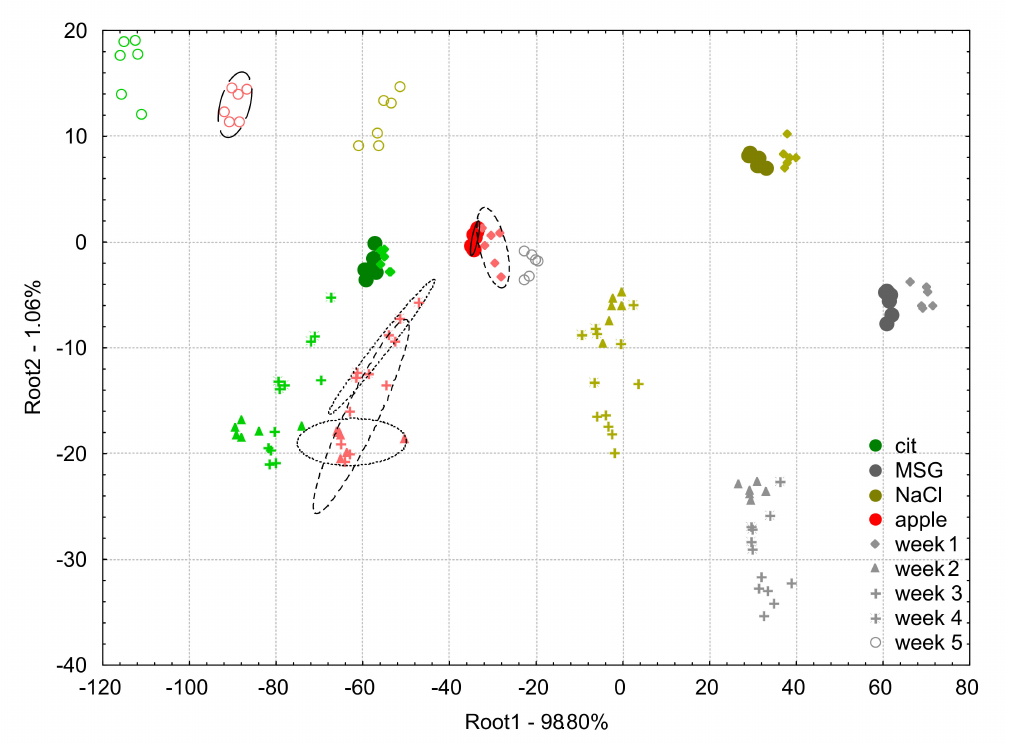
Figure 5. Linear discriminant analysis plots for raw data (non-drift corrected) of the e-tongue measurements of apple juice samples (red symbols) and model solutions: citric acid (green symbols), NaCl (gold symbols), and MSG (gray symbols). The solid circles indicate the measurements on week 0 which was used to build the linear discriminant analysis model, and the di ff erent symbols (diamond, triangle, plus, asterisk, and circle) stand for the di ff erent weeks 1–5,